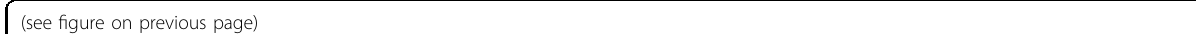
Fig. 1 Pyroptosis is involved in ovulation of zebra fi sh. a Ovulation arti fi cially induced by injection of hCG (20 IU/ fi sh) in zebra fi sh. b SYTOX green staining of follicles during ovulation. c Statistical analysis of the dead cell number after SYTOX staining. Data are presented as mean ± SEM (* P < 0.05, ** P < 0.01, *** P < 0.001 vs 0 h, one-way ANOVA). d Statistical analysis of the TUNEL assay. Data are presented as mean ± SEM (** P < 0.01, vs 0 h, one- way ANOVA). e TUNEL assay showed the dead cells in follicular cells during ovulation. Signals are indicated by the white arrow. f The protein expression changes of Caspase-1, IL-1 β , GSDMEb, and β -actin during ovulation detected by western blot. g Morphological changes of follicular cells during ovulation of zebra fi sh viewed by a transmission electron microscope (TEM). n, nucleus of endothelial cell; e, erythrocyte; p, pericyte. Scale bar: 5 μ m. h Targeted disruption of the zebra fi sh gsdmeb gene by CRISPR/Cas9 system. The above panel shows the location of the gRNA binding site on the gsdmeb gene of zebra fi sh. WT, wild-type; M, homozygous mutant line of F2 generation zebra fi sh. The below panel shows the sequencing results of gsdmeb from wild-type ( gsdmeb + / + ), heterozygous ( gsdmeb + / − ), and homozygous ( gsdmeb − / − ) zebra fi sh. i Schematic protein structure of GSDMEb from wild-type and mutant zebra fi sh based on sequencing results. j The ovulation rate in wild-type, heterozygous and homozygous gsdmeb mutant female zebra fi sh. Data are presented as mean ± SEM (** P < 0.01 vs wild-type, one-way ANOVA). k – m The effects on hCG-induced ovulation by administration of a Caspase-1-speci fi c inhibitor VX-765 ( k ), a GSDMEb-derived peptide inhibitor Ac-FEID-CMK ( l ), or an Nlrp3-speci fi c inhibitor MCC950 ( m ). Data are presented as mean ± SEM (* P < 0.05, ** P < 0.01, *** P < 0.001 vs hCG treatment group, one-way ANOVA for panels k and l , t test for panel m ). n Model of pyroptosis involvement in zebra fi sh